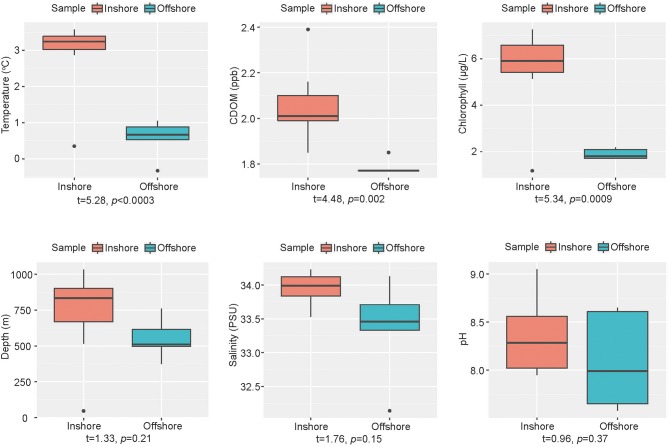
Boxplots of environmental variables between groups. Orange, inshore group; blue-green, offshore group. Welch's t-test between two groups was performed by R.